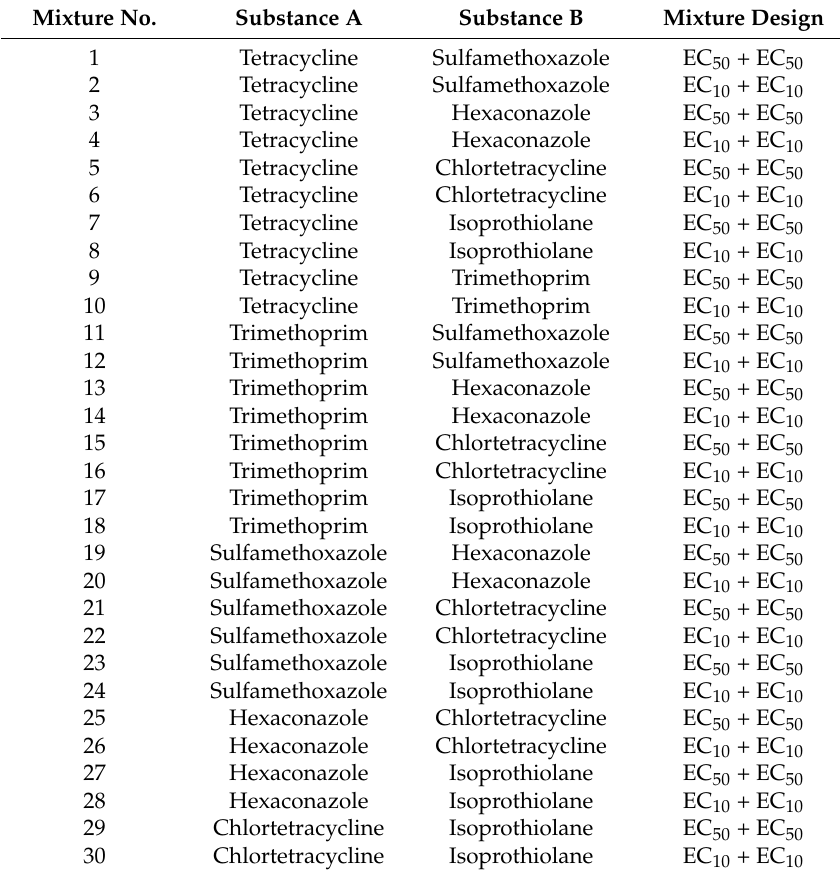
Table 1. Binary mixture designs for target pesticides and pharmaceuticals. Mixture